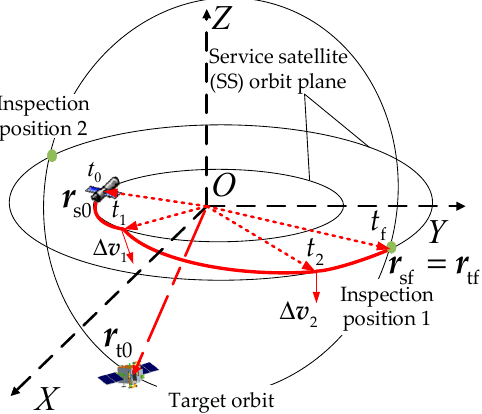
Figure 1. Task flow of multisatellite flyby inspection.